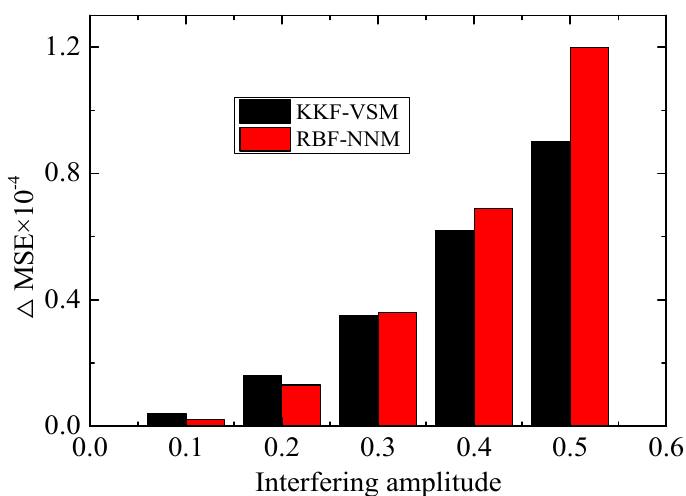
Figure 14. Noise sensibility of KKF-VSM comparing with RBF-NNM.